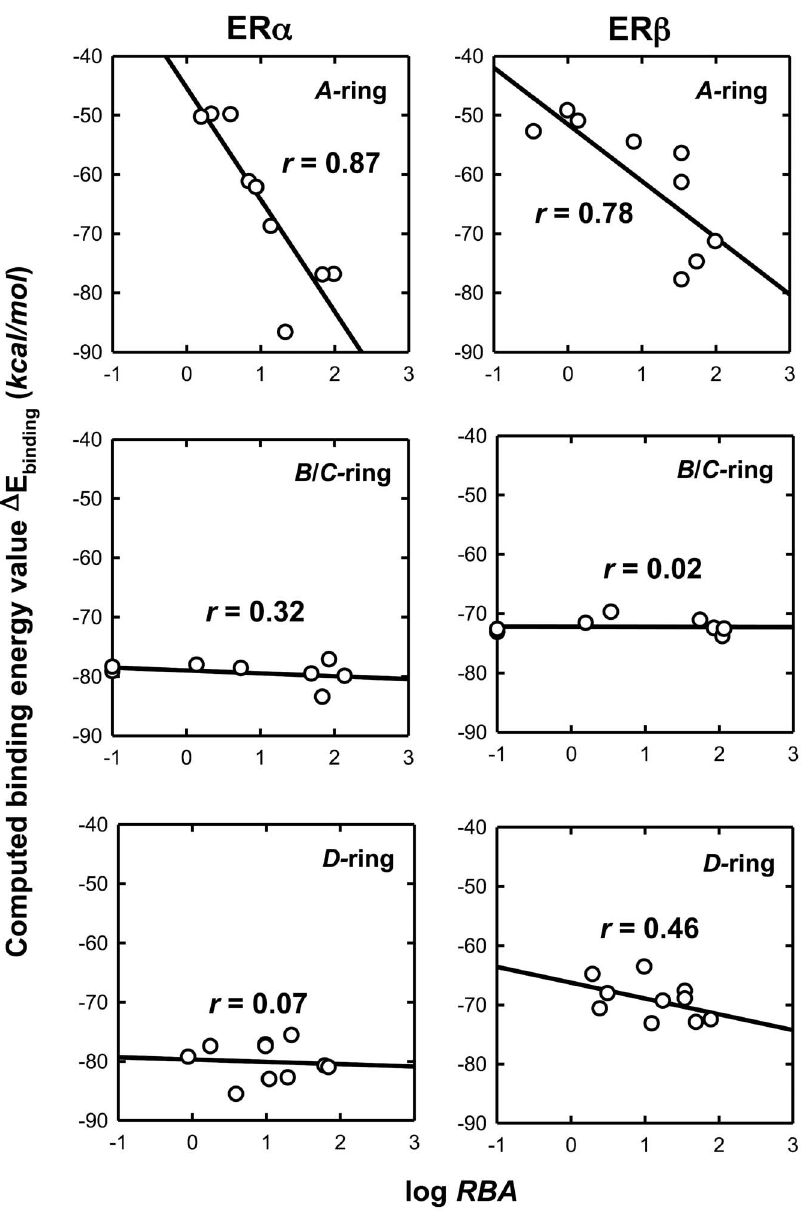
Figure 7. Correlation between log RBA and binding energy calculated with equation (1) and data in Table 1. The correlation coefficient r value is shown in the